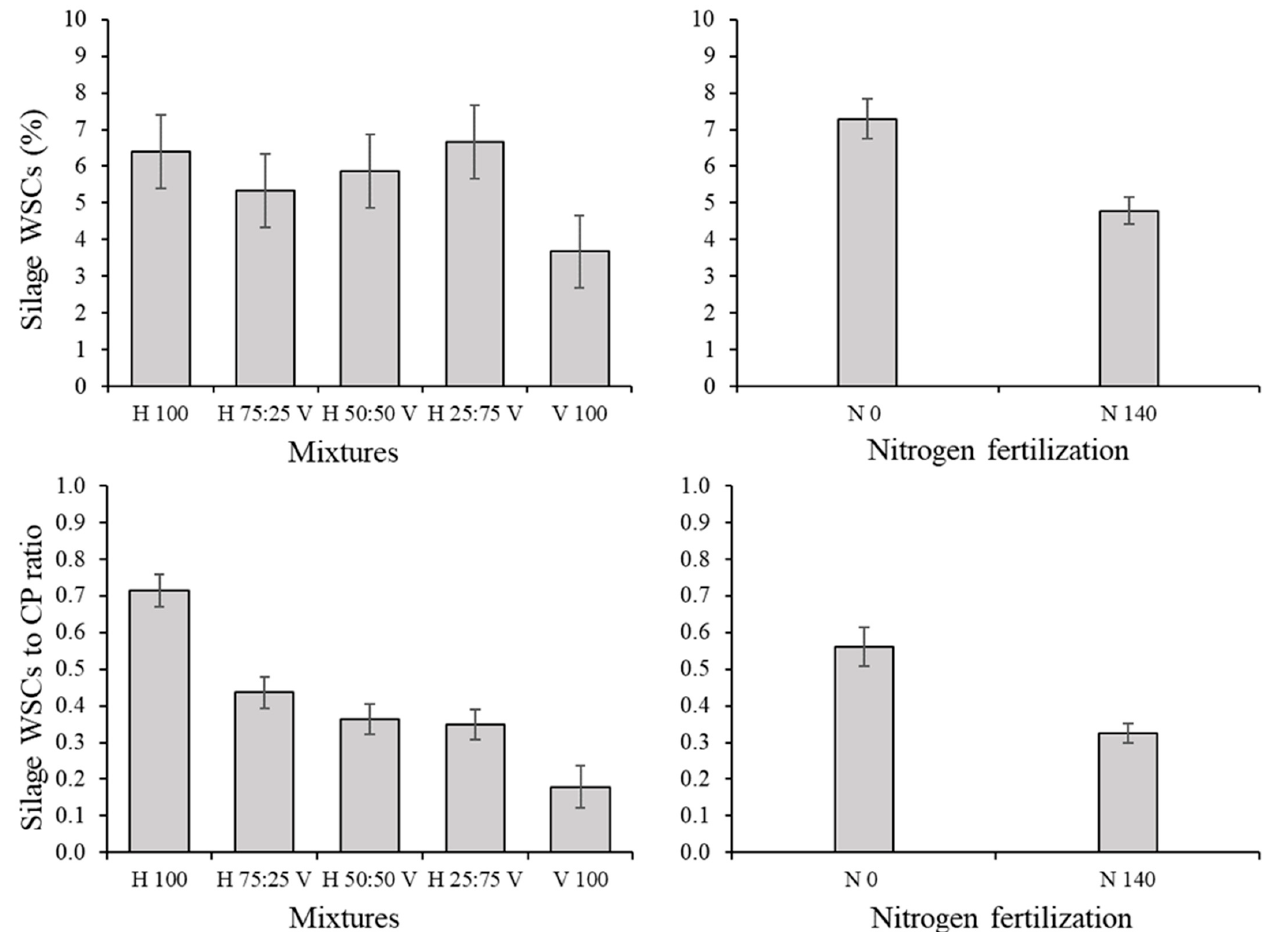
Figure 13. Silage WSC concentration ( above ) and WSC to CP ( below ) as affected by MX mean effect ( left ) and NF mean effect ( right ). On the left, values are LSmeans across all treatments along with standard error estimate of the LSmeans since the design was unbalanced between the faba bean crop ( n = 9) compared to the mixtures and the barley crops ( n = 18). On the right, only data of the barley-containing treatments were used. Each point represents the arithmetic mean ( n = 24) and its computed standard error.